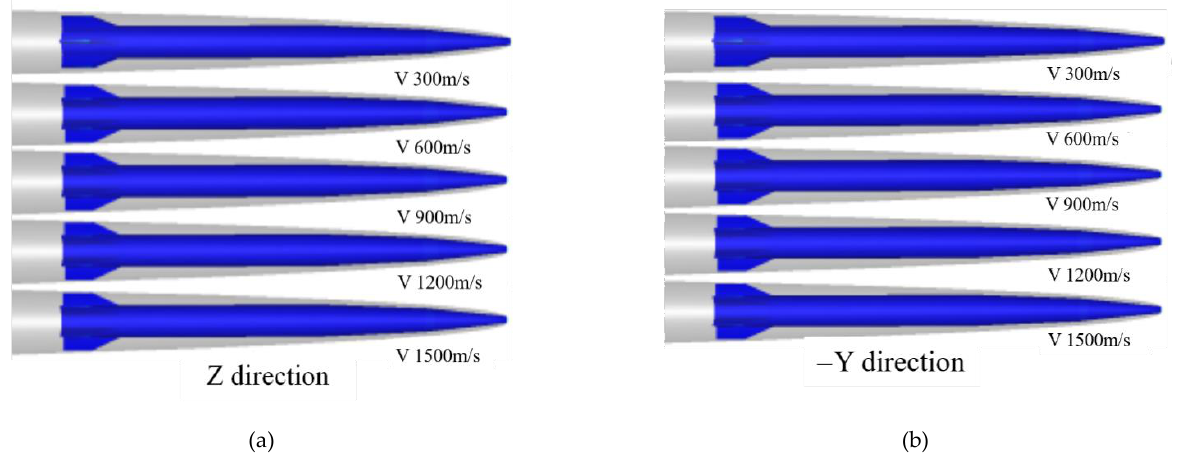
Figure 8. Cavitation morphology with different flow speeds in the directions of ( a ) Z and ( b ) – Y, respectively. (attack angle 0°).